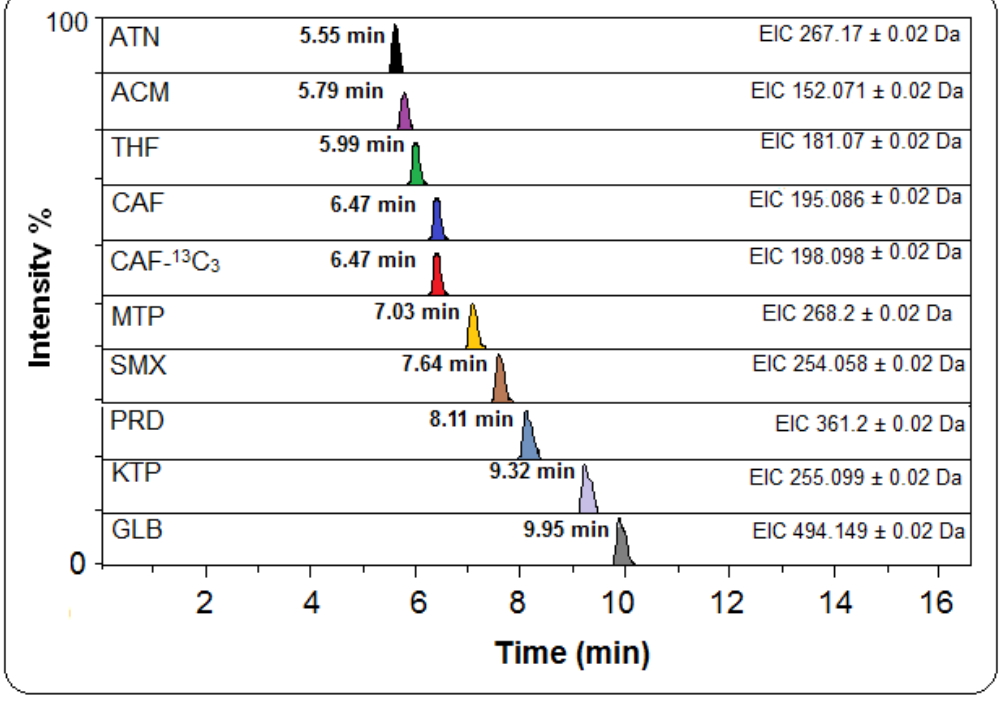
Figure 6. Extracted ion chromatogram (EIC) for all nine pharmaceuticals including caffeine 13 C 3 as internal standard; spiking level 10 ng/mL in STP effluent.